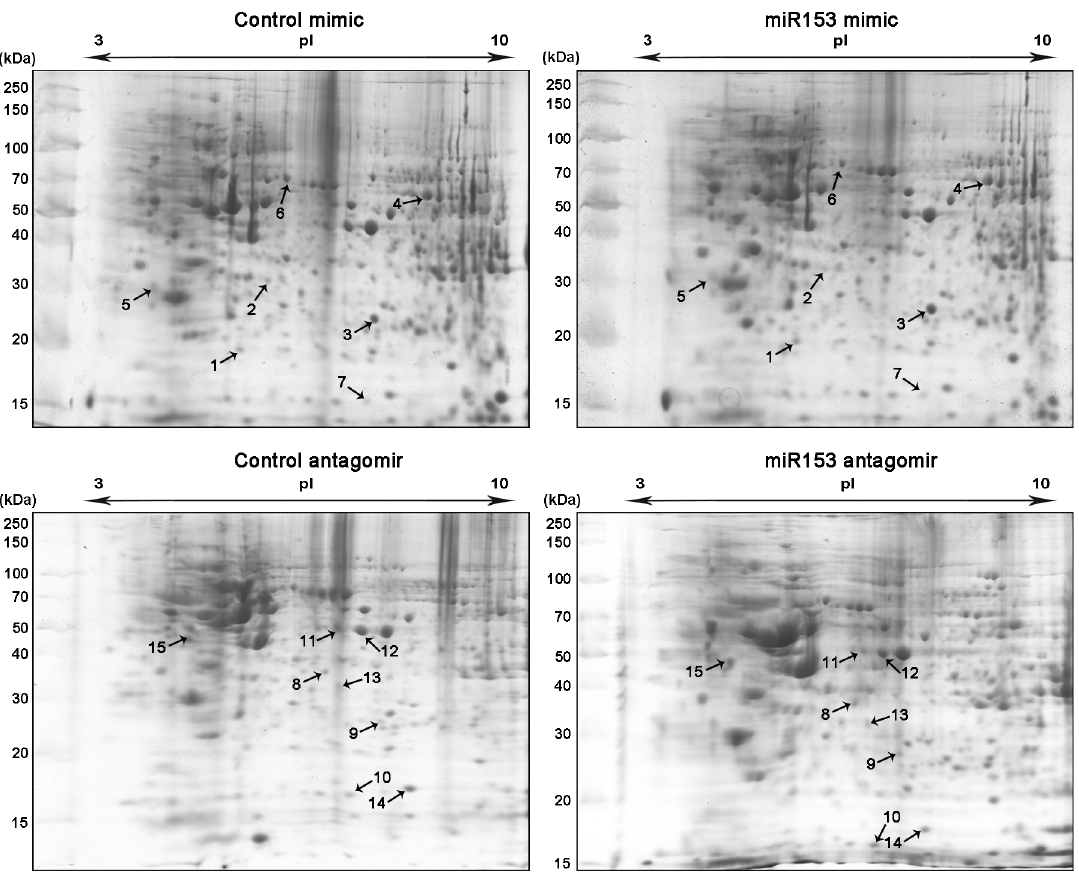
Fig 2. Comparative proteomic profiling in SH-SY5Y. Two-dimensional gels of control mimic, miR-153-3p mimic, control antagomir and miR-153-3p antagomir transfected cells. n = 3 for all experiments. Numbers (1 – 15) represent differentially expressed protein spots identified by MS, reported in Table 1.